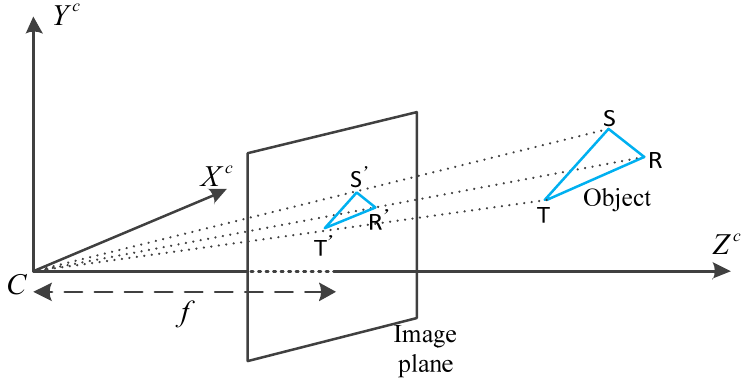
Figure 2. Representation of the camera frame with respect to the pinhole projection